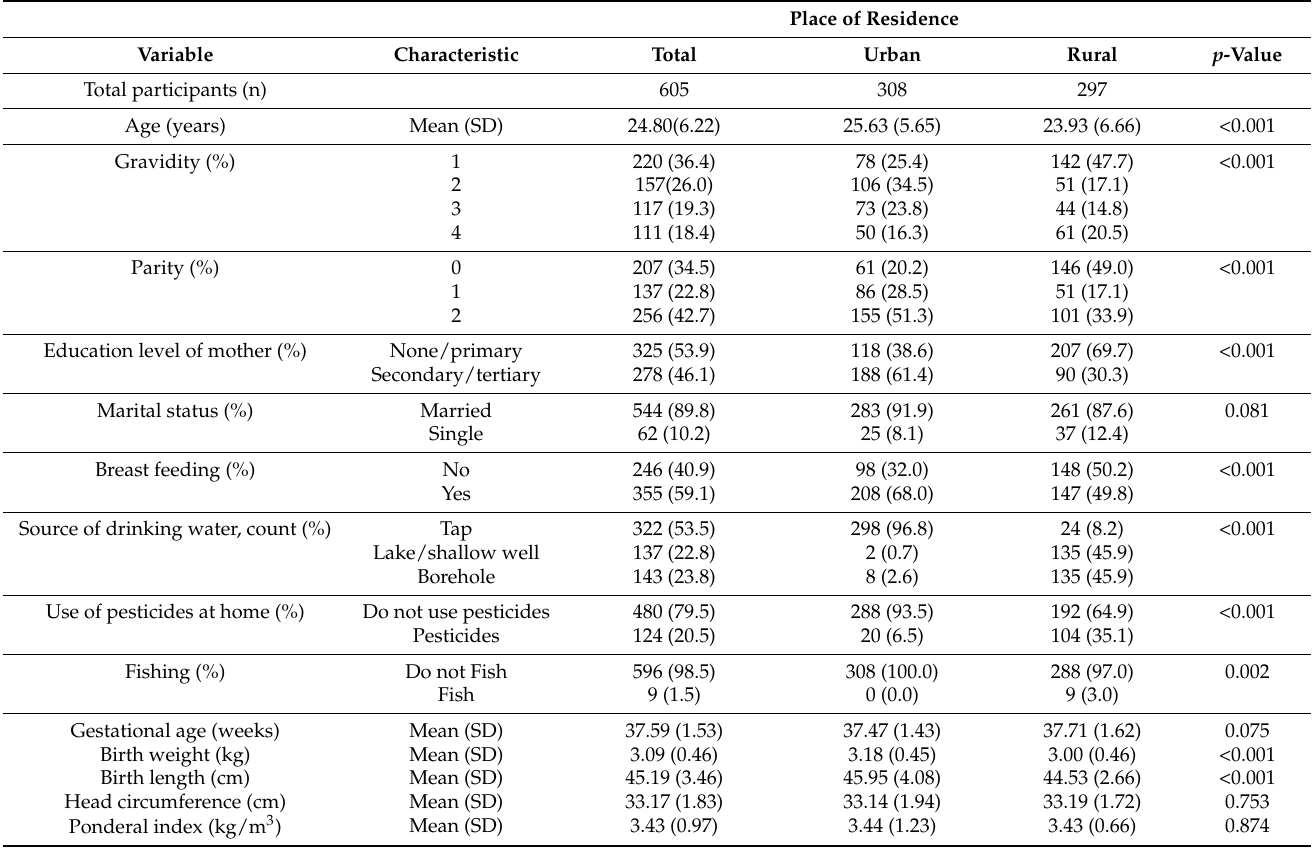
Table 1. Sociodemographic characteristics of the mothers and